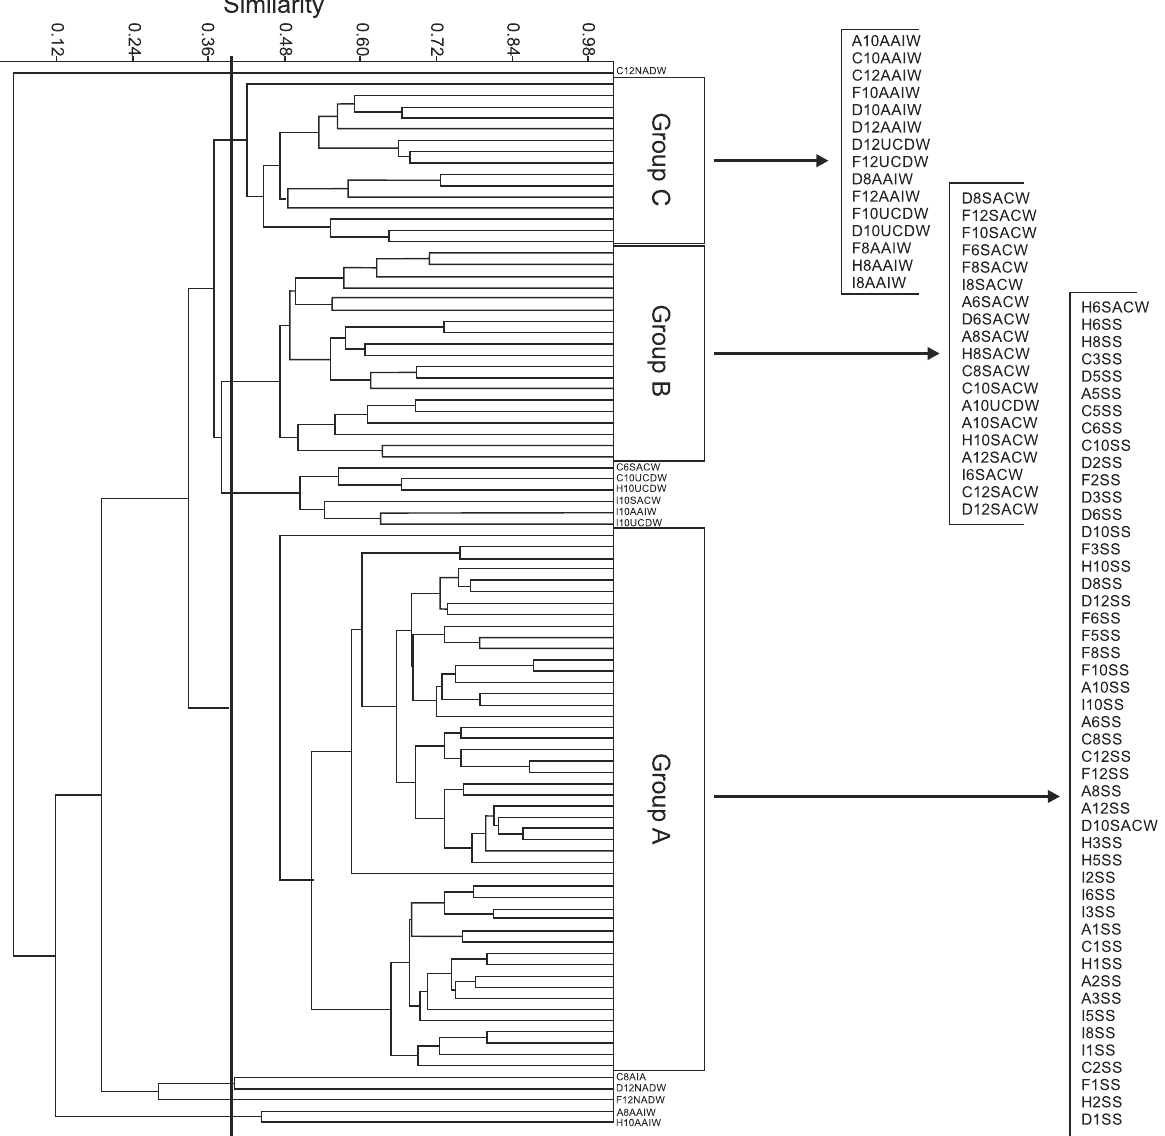
Figure 5. Cluster analysis based on species composition in samples from the water masses in the Campos Basin, central Brazilian coast, during the dry season. For the analysis, the Sørensen-Dice coefficient with average linkage method was used . Different groups indicate faunistic zones, defined at 40% similarity. In data labels: letters indicate transect, number indicate station, SS – Subsurface Water, SACW – South Atlantic Central Water, AAIW – Antarctic Intermediate Water, UCDW – Upper Circumpolar Deep Water, NADW – North Atlantic Deep Water